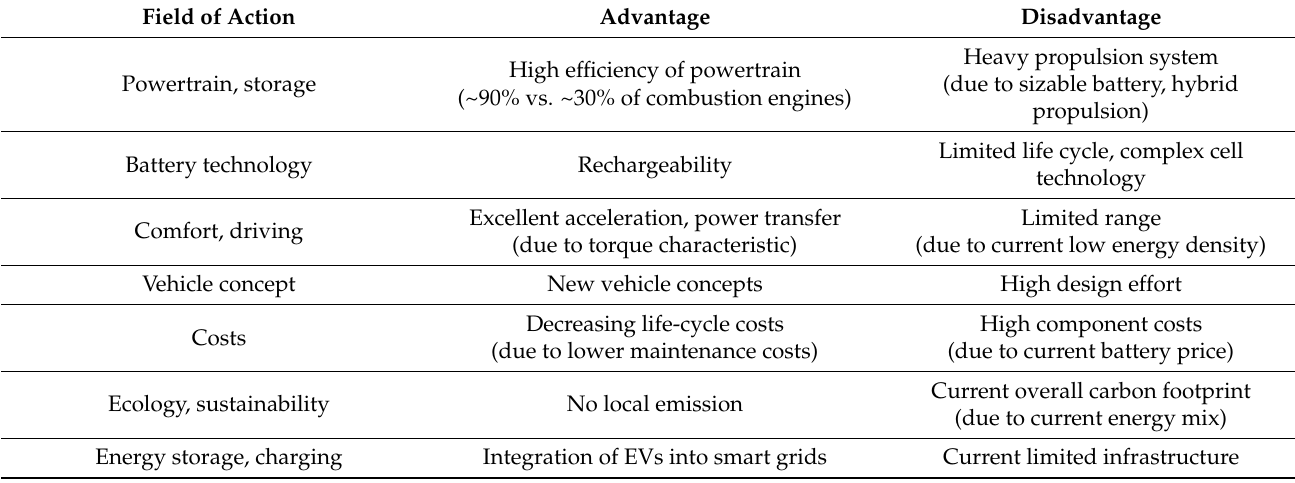
Table 2. EV advantages and disadvantages in terms of technology, user experience, sustainability, and costs, elaborated from